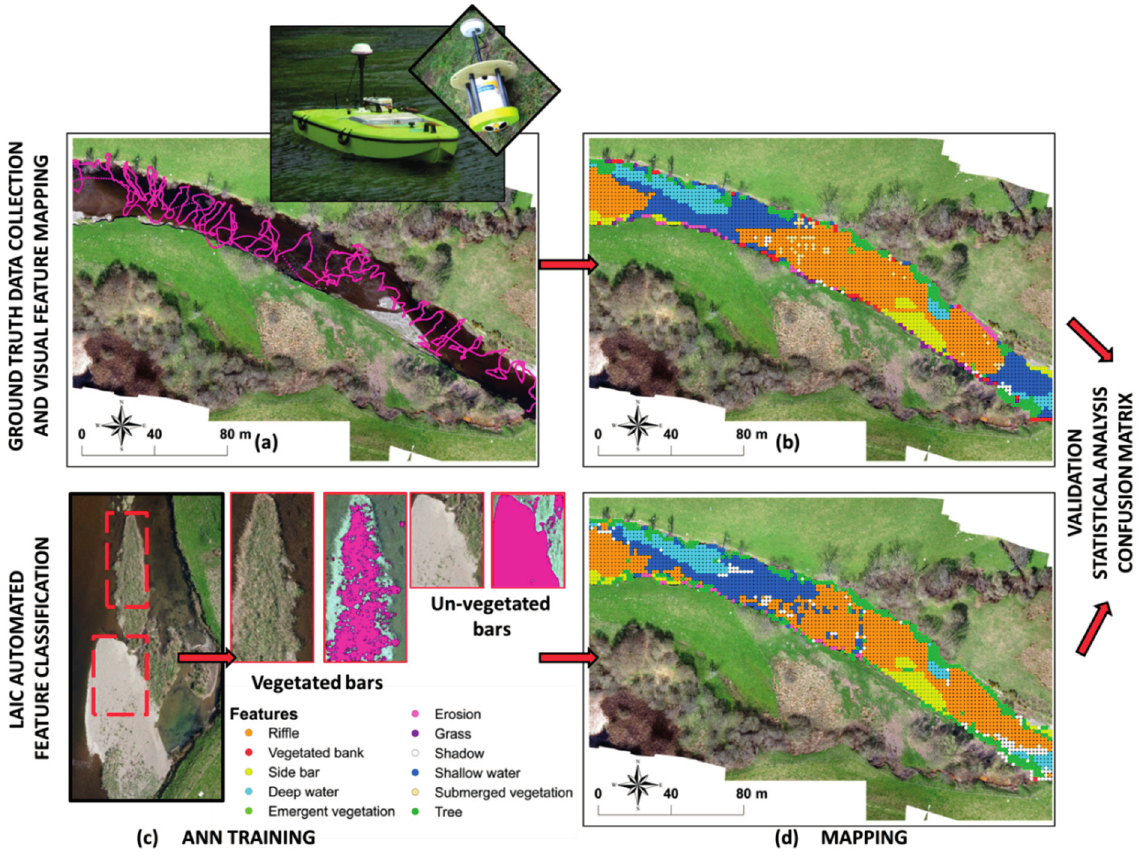
Figure 3. Detailed diagram of the workflow for the Leaf Area Index Calculation (LAIC) image classification and validation based on [18] ( a – d ). ( a ) 300 m section within the reach showing the ADCP measurements obtained along with a detailed image of the radio control boat and ADCP sensor used; ( b ) Map showing the hydromorphological features obtained from visual identification on a 2 m × 2 m regular grid; ( c ) Examples of sections selected for and outputs obtained from the Artificial Neural Network (ANN) training; ( d ) Map showing the hydromorphological feature classification obtained with ANN on a 2 m × 2 m regular